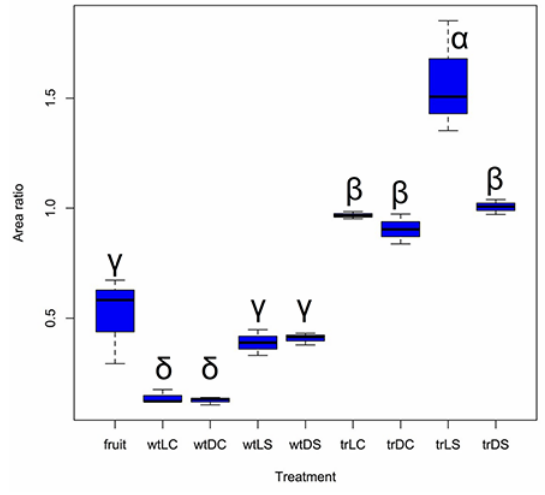
Fig. 7 Ratio of the content of dihydrocapsaicin to capsaicin in fruit and cell suspension cultures of C. annuum ‘Serrano’ quantitated as the ratio of the respective peak areas in DSA-MS (area ratio). Labels: fruit – C. annuum ‘Serrano’ extract from the green fruit; wt – extract from suspension cells cultured after bombardment with microprojectiles treated with deionized water; tr – extract from suspension cells cultured after bombardment with plasmid loaded microprojectiles; LC – DC, LS, DS, as in Fig. 5. Different Greek letters over the boxes indicate statistically significant ( p < 0.05) differences (ANOVA and Tukey’s HDS; R statistical software